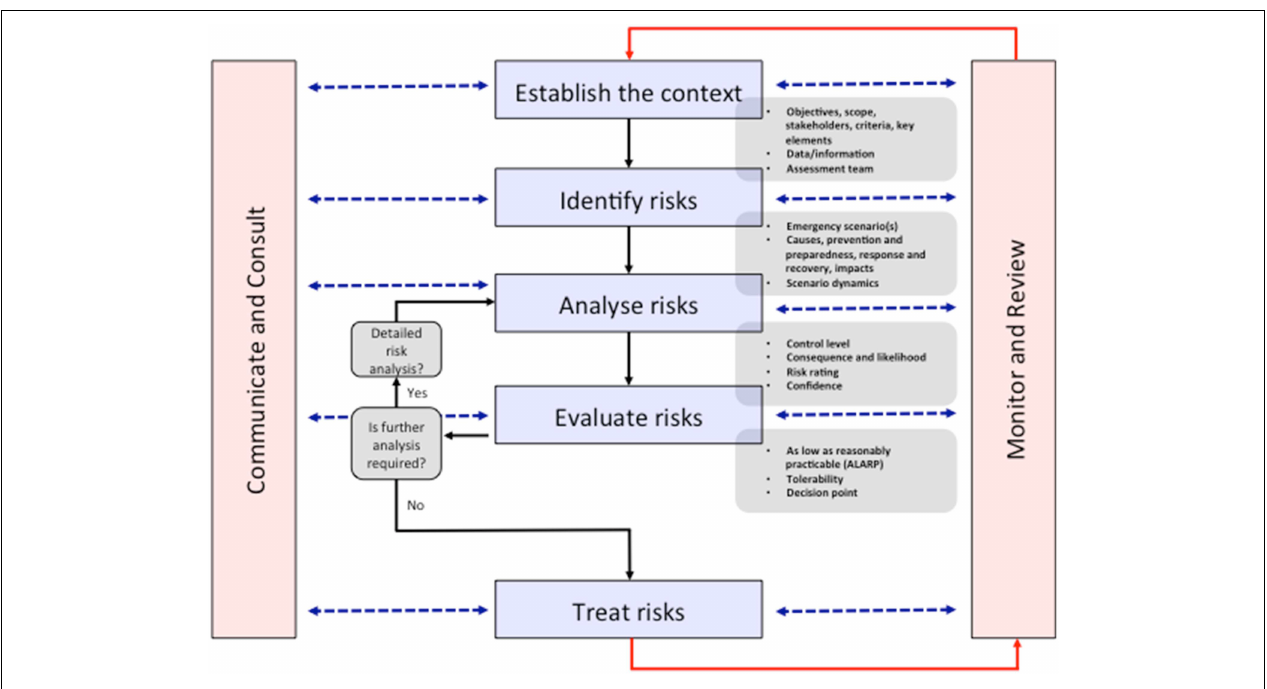
FIGURE 1 | The emergency risk management process. In the context of reframing antibiotic resistance as a disaster risk management problem, all stakeholders are identified in the “Establish the context” stage. An indicative list of stakeholders is shown in Table 1 . The identifying, analyzing, evaluating and treating risk stages are undertaken via communication and consultation with stakeholders and monitoring and reviewing by the assessment team. This “bottom-up” approach leads to more successful policy outcomes by establishing solutions consistent with the socio-cultural context of the stakeholders. Modified from The Australian Government (2010).